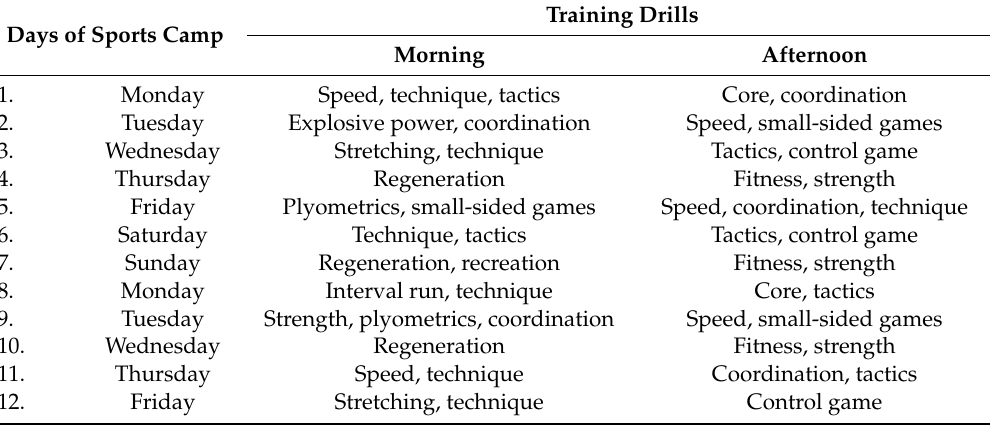
Table 1. Overview of the 12-day training load during the sports camp in the preparation period. Days of Sports